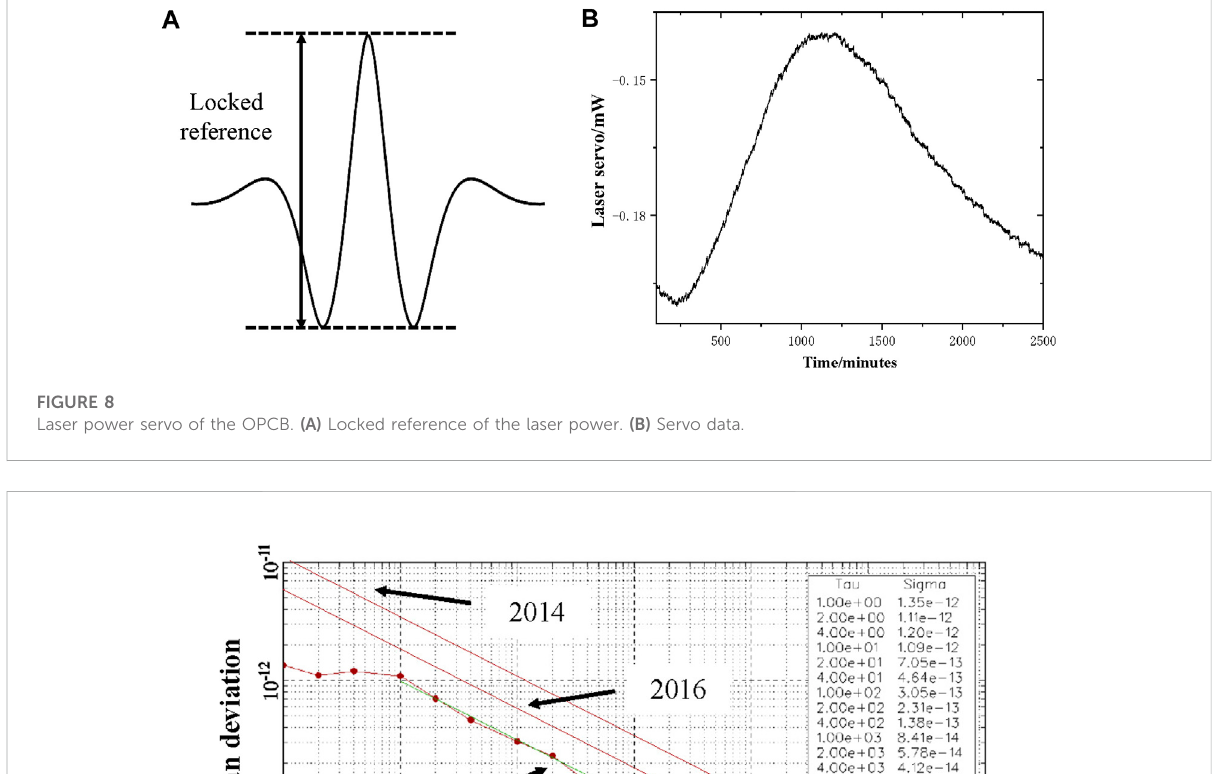
Overlapping Allan deviation of the OPCB. In 2014, the short-term stability reached 1 × 10 − 11 / (cid:1) √ τ . At present, the short-term stability is 3 × 10 − 12 / 6 × 10 − 12 /